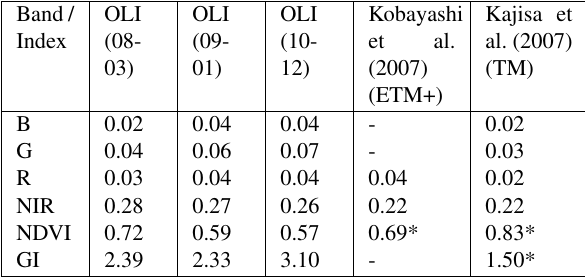
Table 3: Comparison of the found values for the terrain shadow parametrization method on August 3 rd (DOY 212),